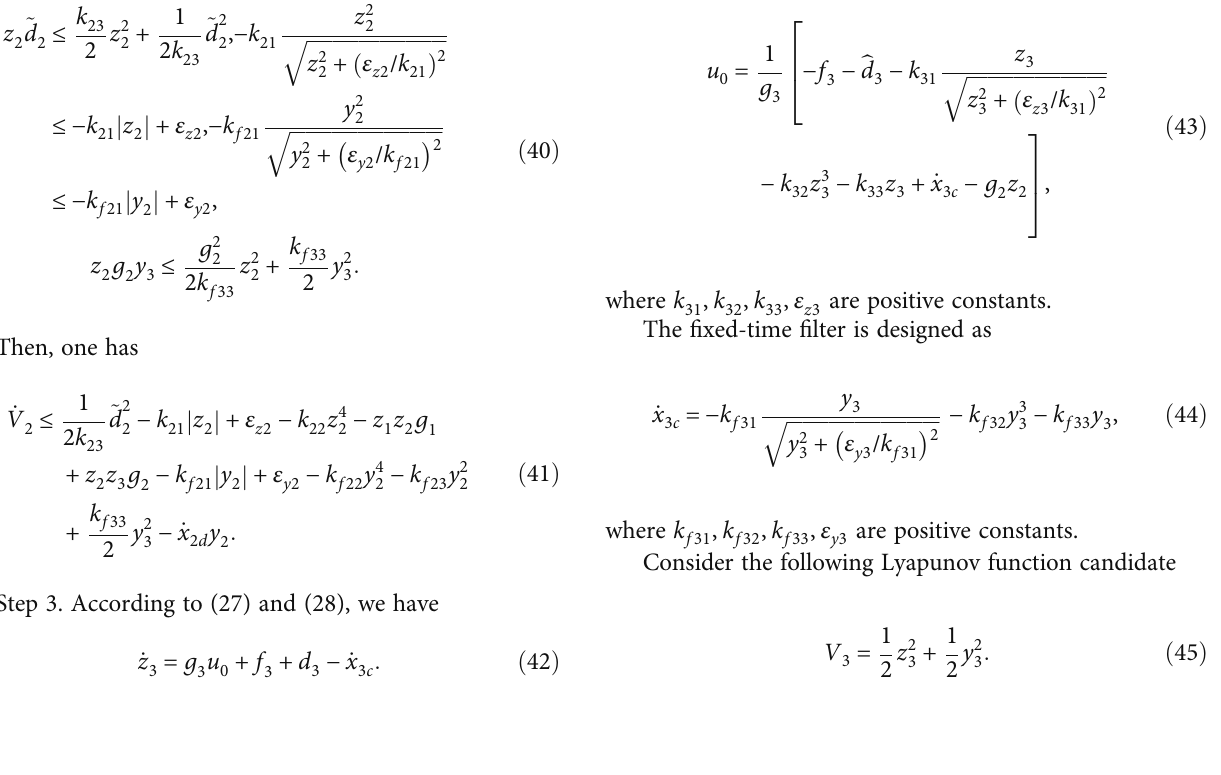
1 and the trajectory of